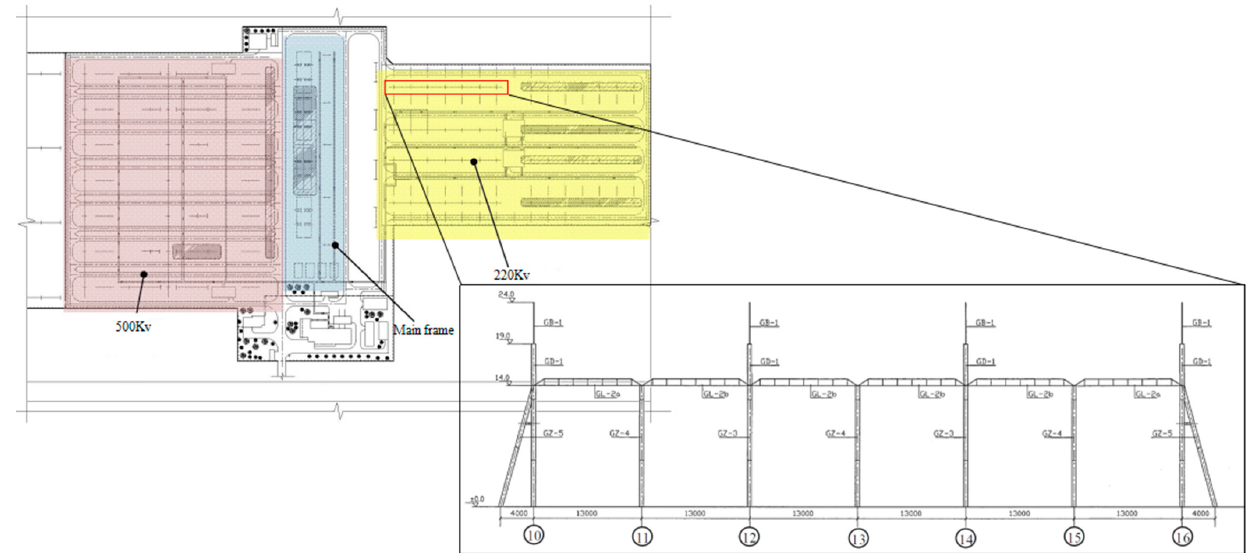
Figure 4. Layout of the experimental transformer substation.